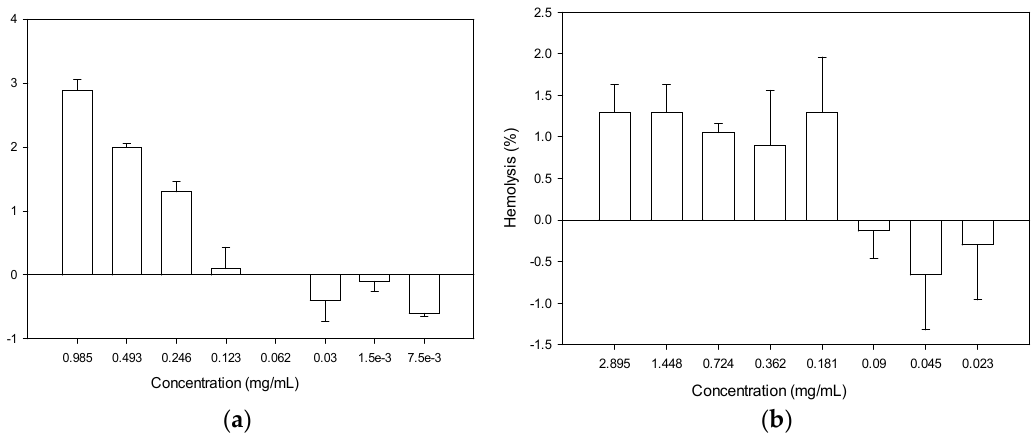
Figure 7. Resistance potentials of the test organisms against the recombinant peptides: ( a ) fold change in MIC of recombinant defensin-d22; ( b ) fold change in MIC of recombinant actifensin.